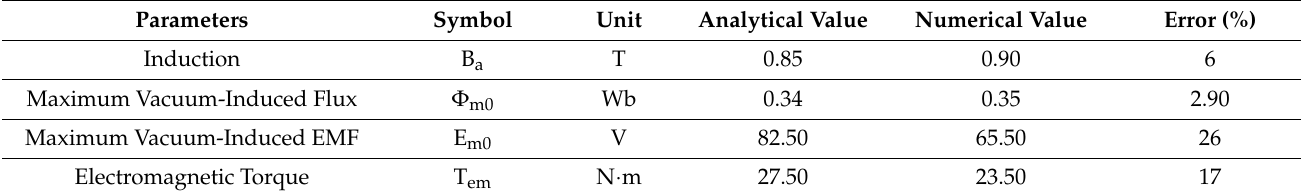
Table 3. Analytical results vs. numerical results of the PMSG electromagnetic